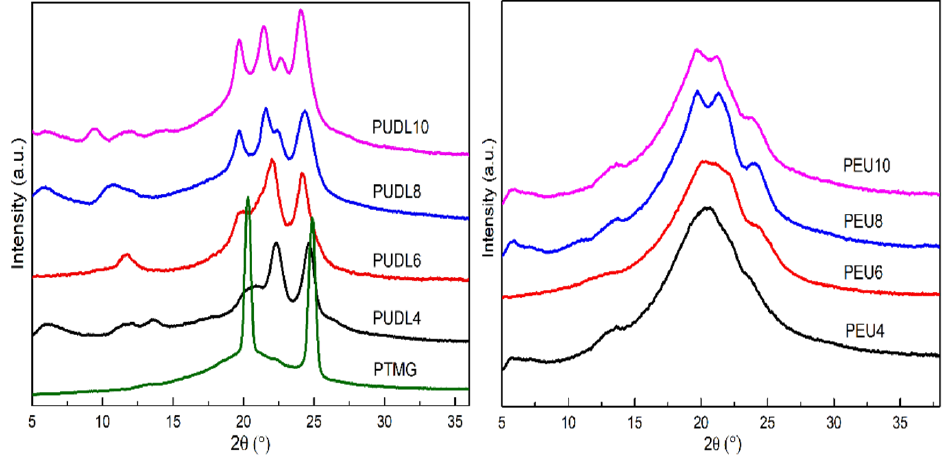
Figure 8. WAXD patterns of PTMG, PUDL and PEU.